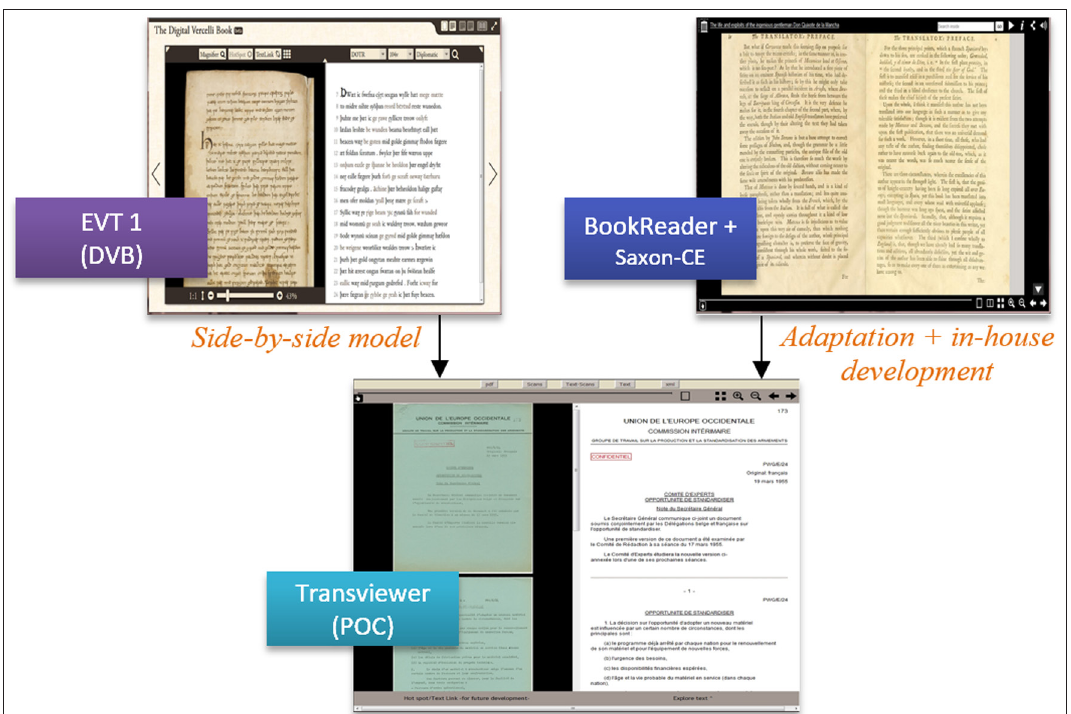
Figure 4: Transviewer Proof of Concept